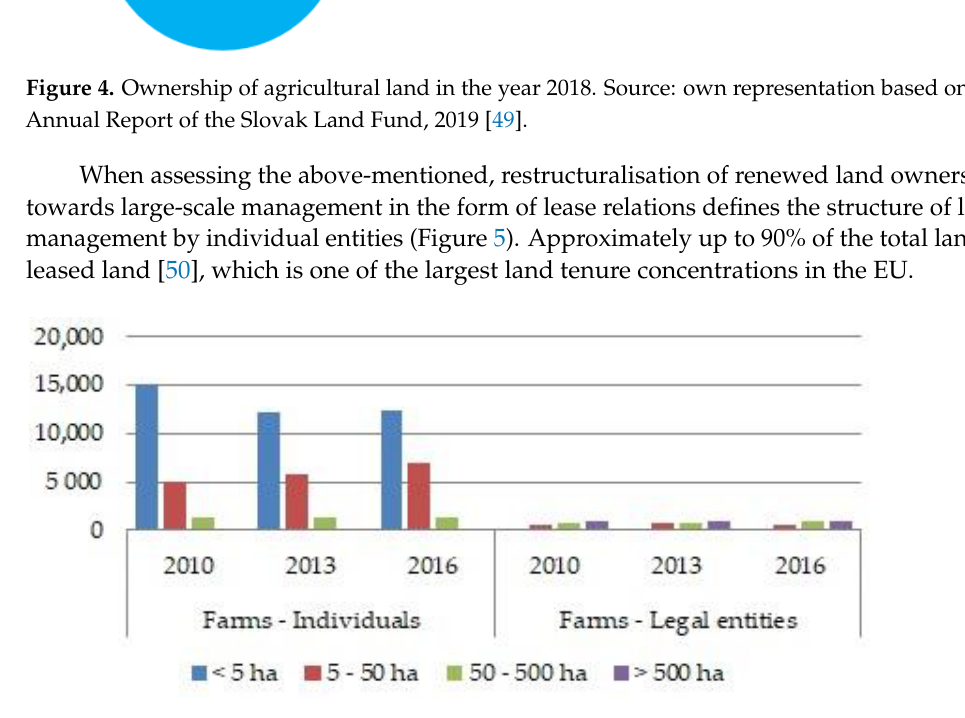
Figure 5. Structure of farms according to the size of the cultivated land, 2010–2016. Source: own representation based on data from the Statistical Office of the SR [51–53].